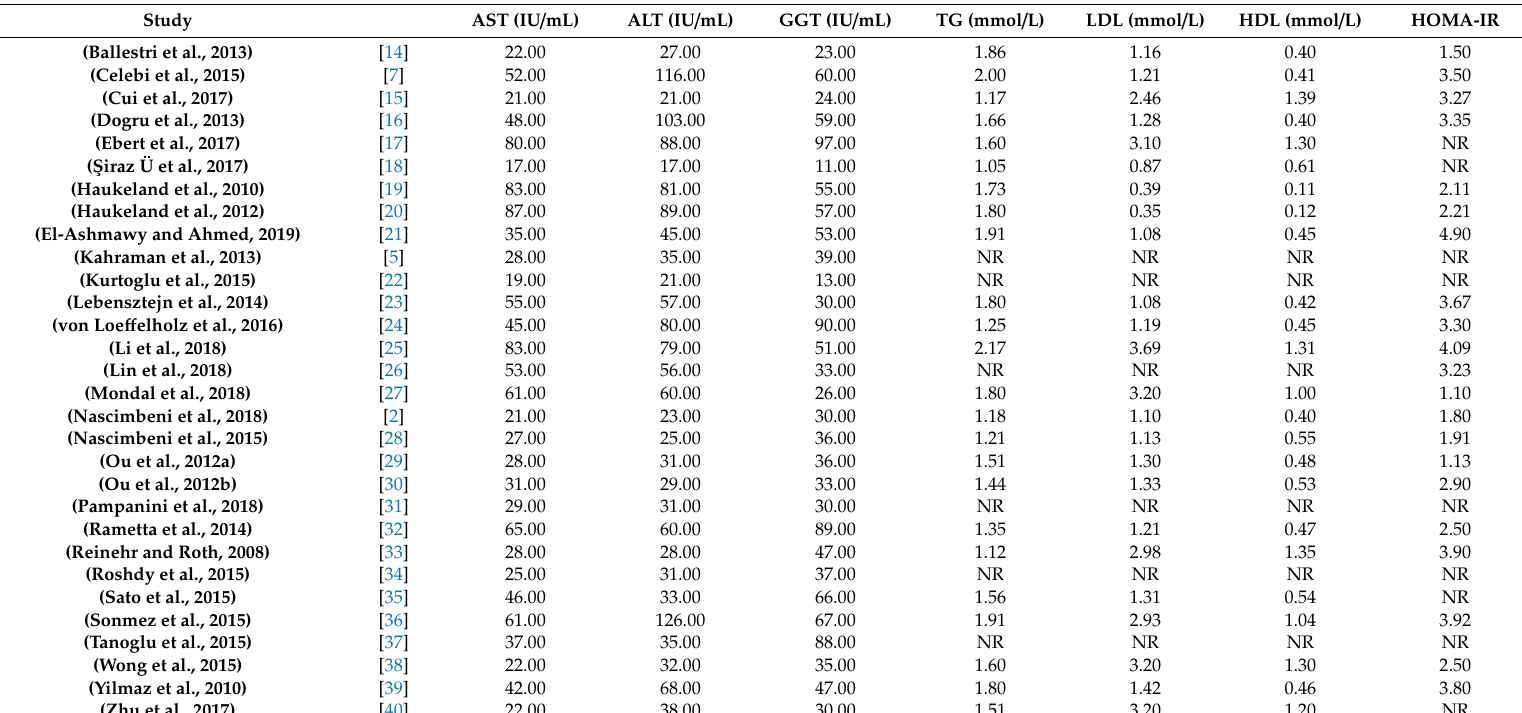
Table 2. Characteristics of clinical parameters of the studies included for the meta-analysis of fetuin-A, fetuin-B, and